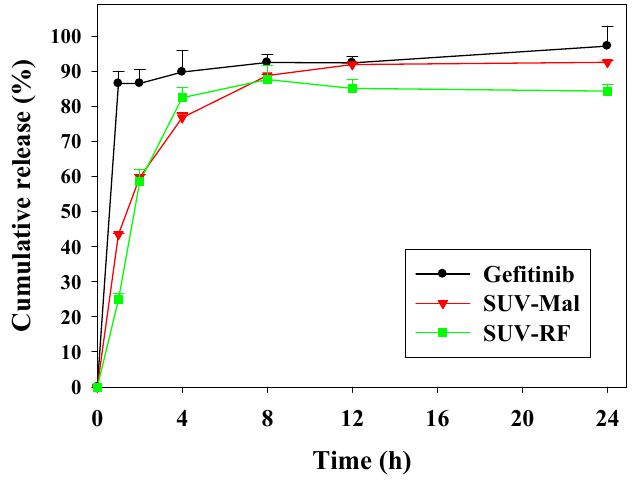
Figure 2. In vitro release of gefitinib from SUV-Mal and SUV-RF. The gefitinib release from liposomes or free drug was conducted in dialysis bag at pH 7.4 PBS with 2% Tween 80 at 37 °C.